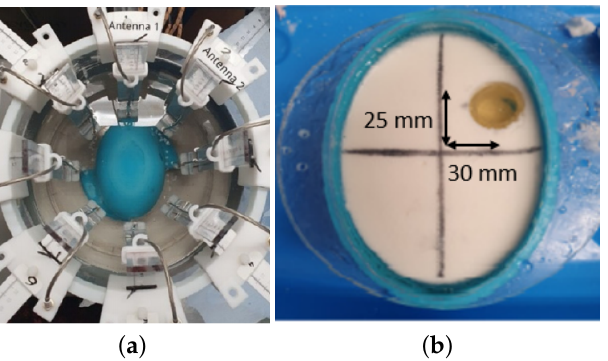
Figure 3. ( a ) Custom-made tomographic experimental setup ( b ) Elliptical mould containing the average brain phantom with the blood-mimicking